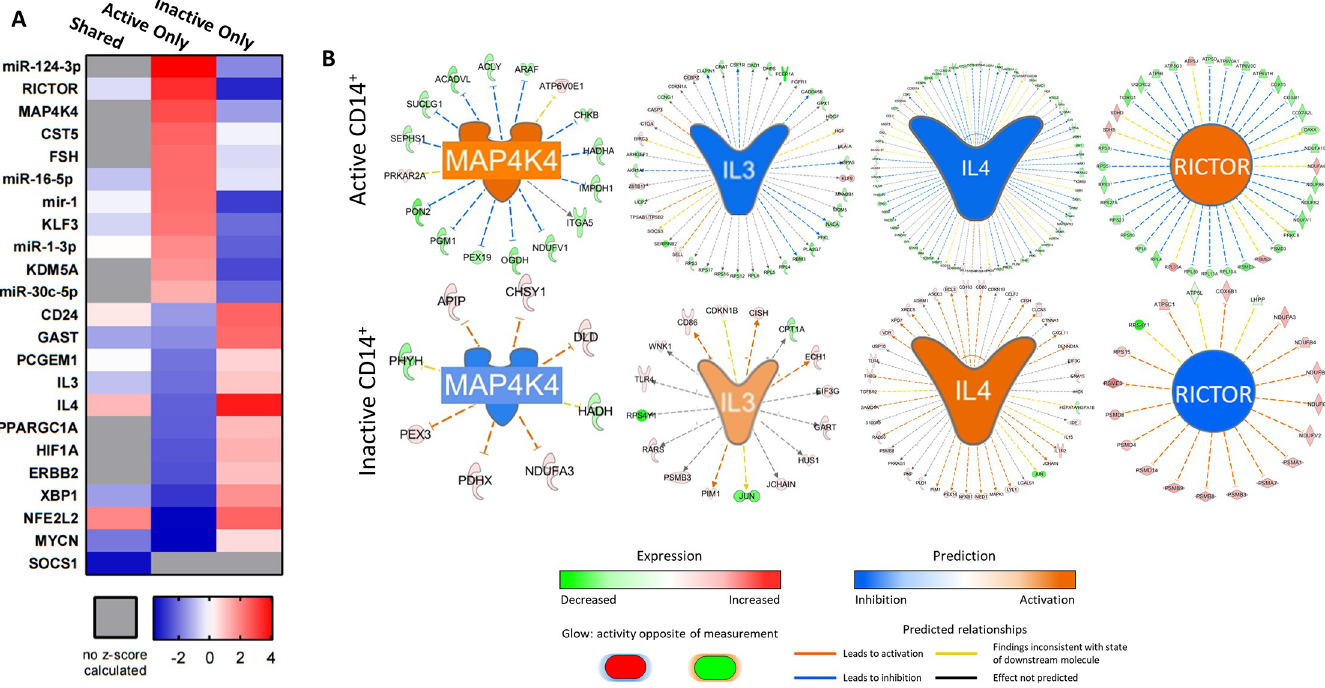
Fig 5. Projected upstream regulator genes in CD14 + monocytes isolated from active and inactive SLE patients. (A) IPA was used to analyze the CD14 + MC dataset and identify putative upstream regulators for active patient monocytes, inactive patient monocytes, and the active-inactive overlap using a p-value cutoff of 0.05. Only genes for which IPA assigned a z-score of � |2| in at least one of the three sets are shown. (B) Representative diagrams showing downstream gene expression changes (outer circles) used to calculate upstream regulators (center).